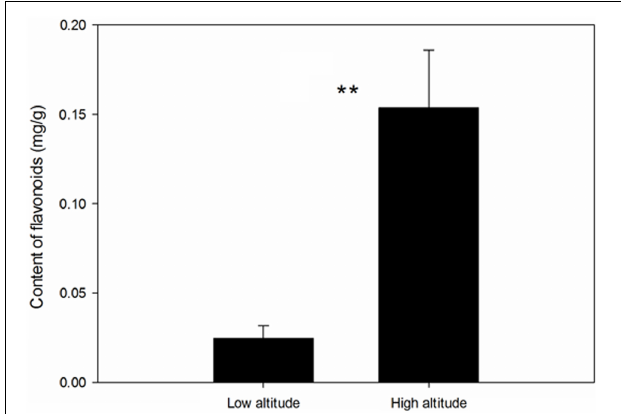
FIGURE 1 | Effect of altitude on flavonoid content in the leaves of Cyclocarya paliurus . ** Indicates significant difference at P < 0.01.